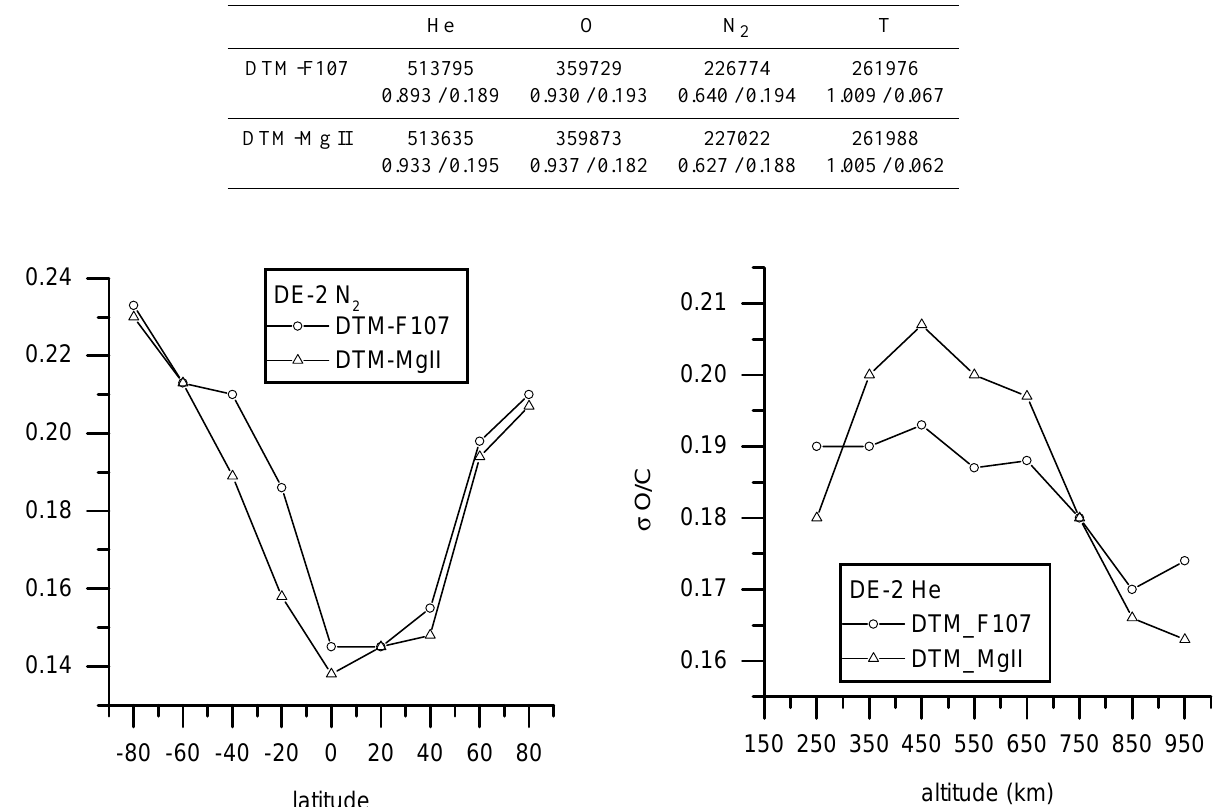
Table 1. The modelling performance with respect to the DE-2 dataset. The number of residuals is given on the first line, followed by their mean and scatter on the second line.